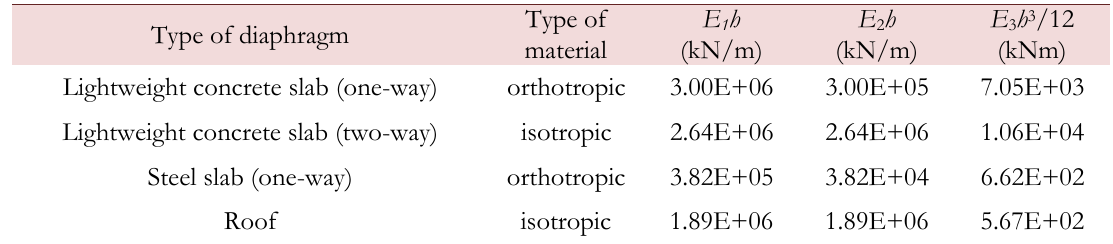
Table 4: Properties adopted for the diaphragms in the numerical